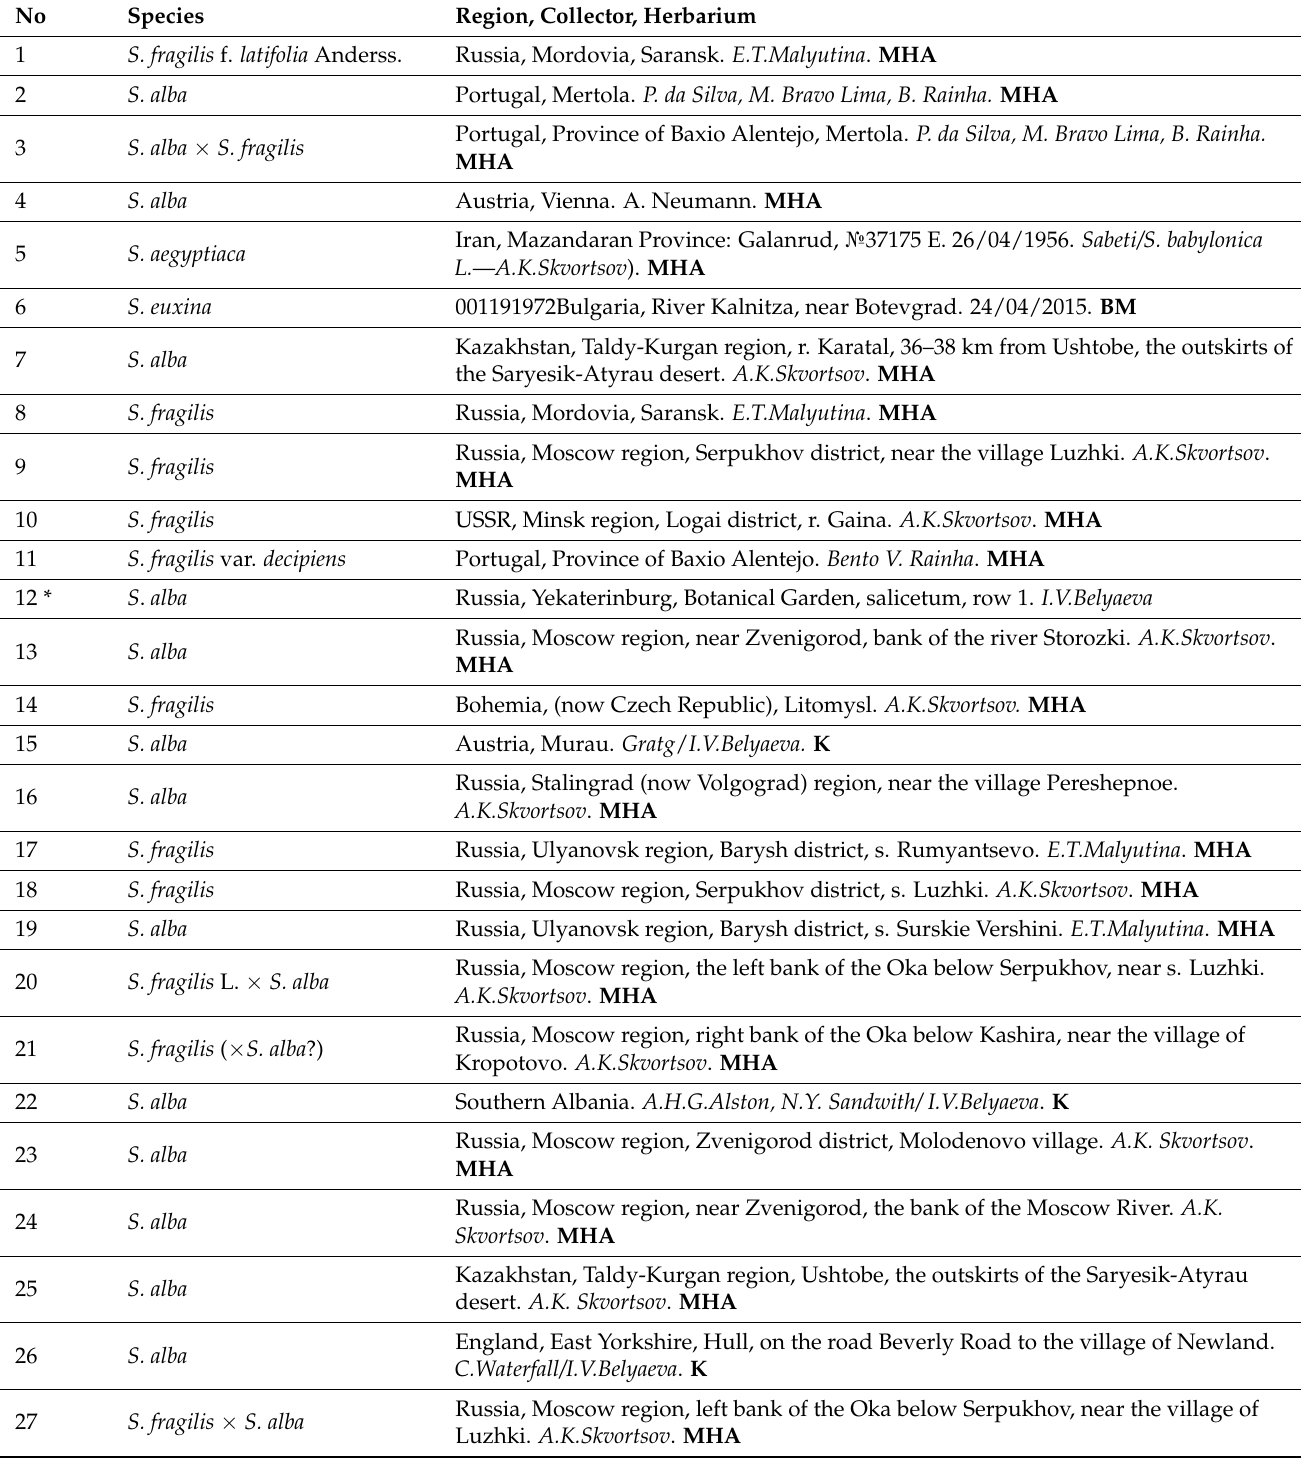
Table A2. Specimen information for S. alba , S. fragilis and S. alba × S. fragilis used in the present study. The Herbaria where the specimens are kept indicated in bold. The specimen number corresponds to the specimen number in Table 1. The specimen number with asterisk (*) means the live